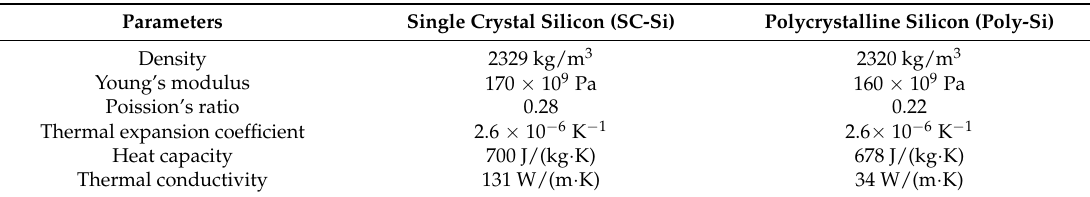
Table 1. Material properties used in COMSOL Multiphysics TM .